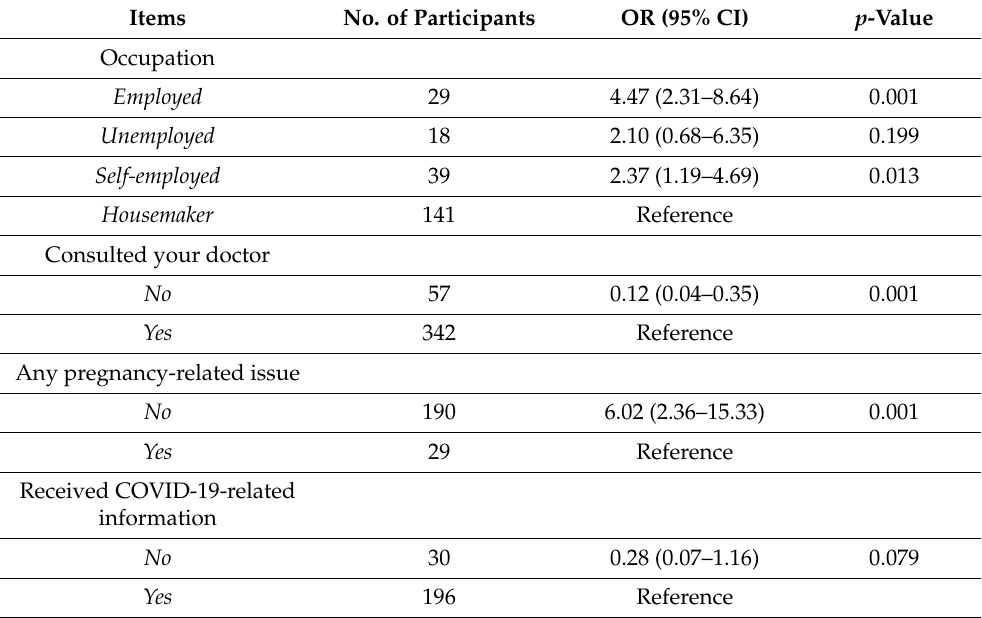
Table 3. Variables affecting COVID-19 vaccination based on multivariate analysis.